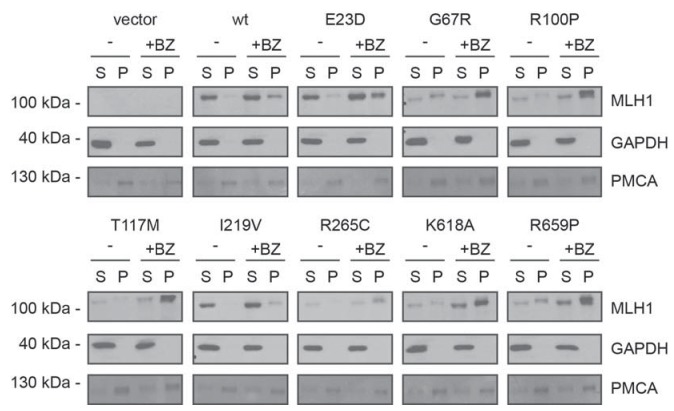
Solubility of selected MLH1 variants.Transfected cells, either untreated (-) or treated for 16 hr with 10 μM bortezomib (+BZ) were lysed by sonication and immediately separated into supernatant (S) and pellet (P) fractions by centrifugation. Western blotting using antibodies to MLH1 was employed to determine the amount of MLH1 in the fractions. Blotting with antibodies to GAPDH and PMCA served as loading controls for the soluble and insoluble fraction, respectively.